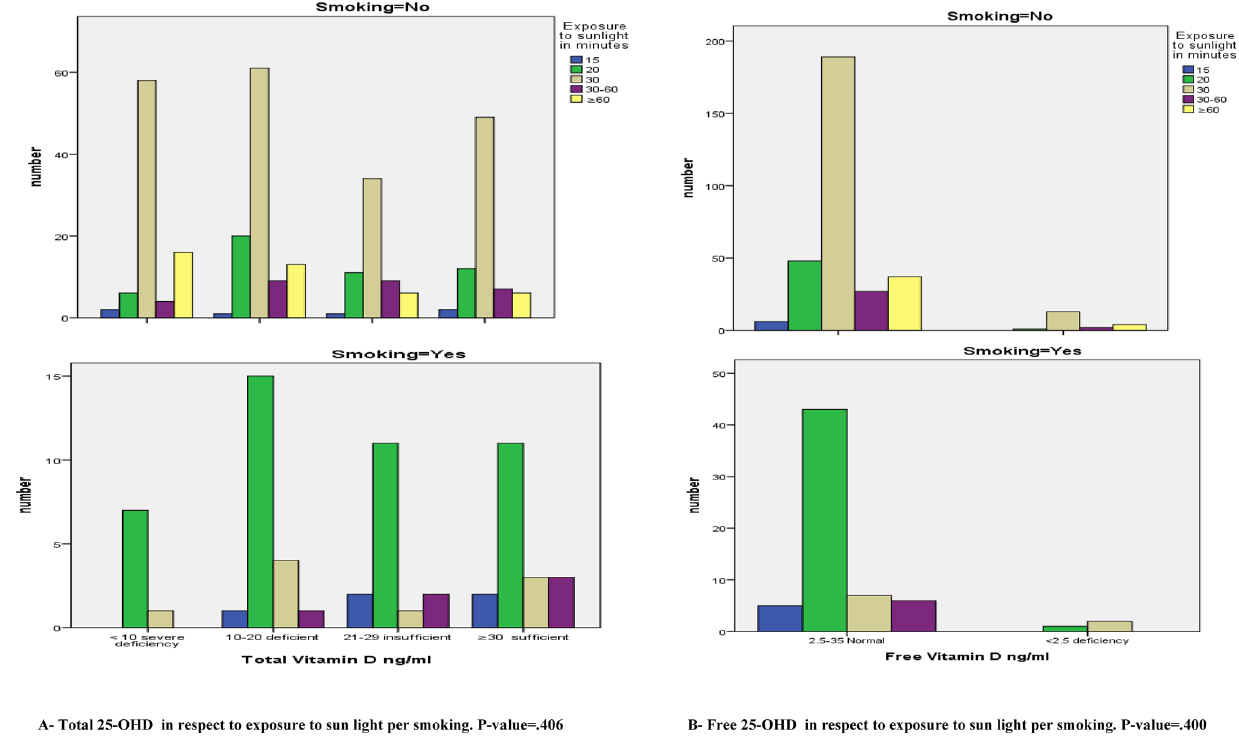
Figure 4. Total and Free 25-OHD in respect to exposure to sun light per smoking. ( A ) Total 25-OHD in respect to exposure to sun light per smoking. P-value = 0.406, ( B ) Free 25-OHD in respect to exposure to sun light per smoking. P-value = 0.400.